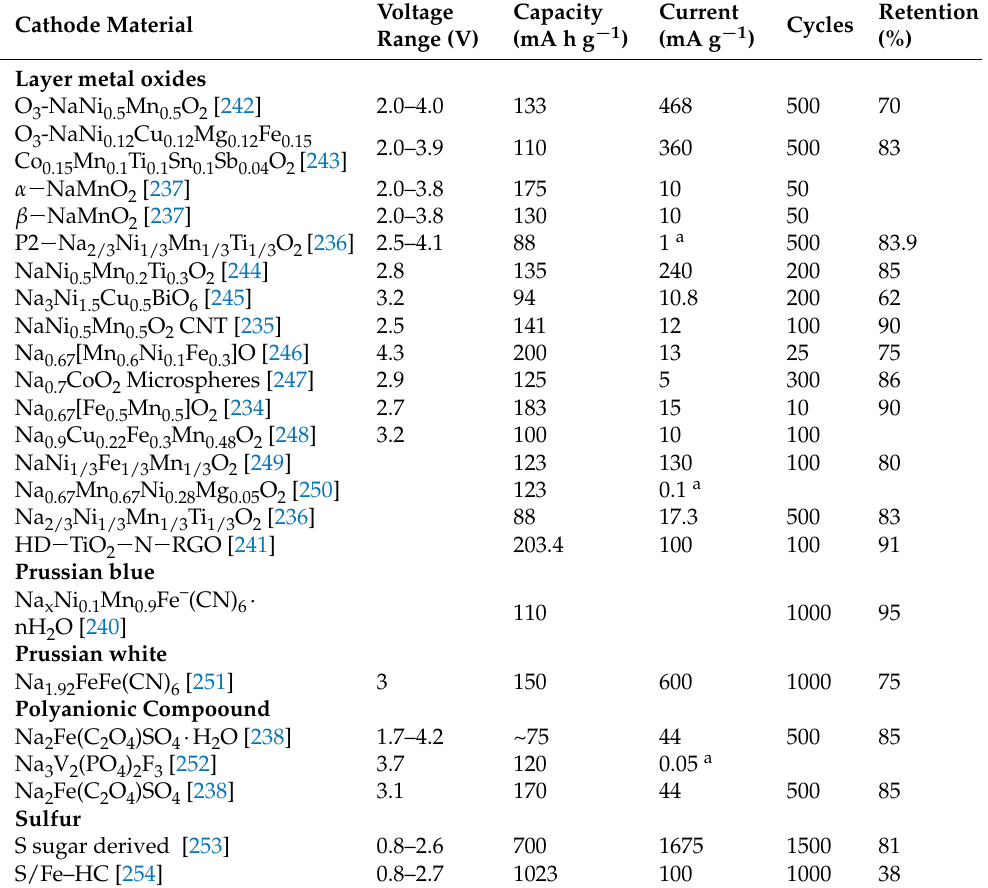
Table 9. Cathode materials for Na-based batteries. Cathode